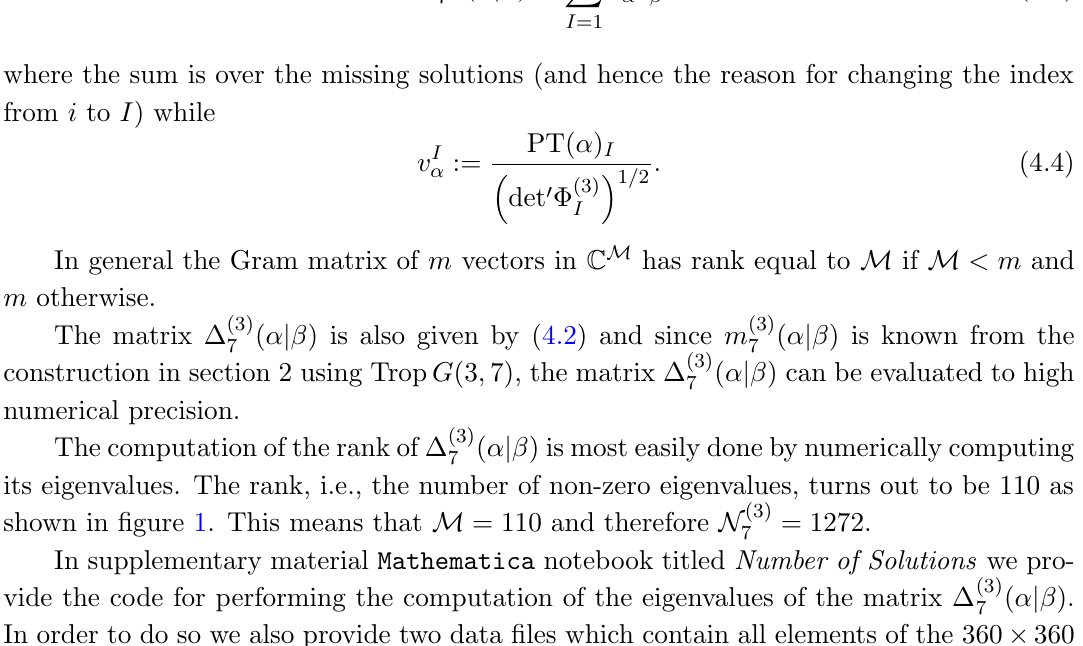
Figure 1 . Absolute values of the 360 eigenvalues of the matrix of di(cid:11)erences (cid:1) (3) line at the location of the 110 th eigenvalue is included in order to visualize the separation between non-zero and vanishing eigenvalues (computations were done using only 50 digits of